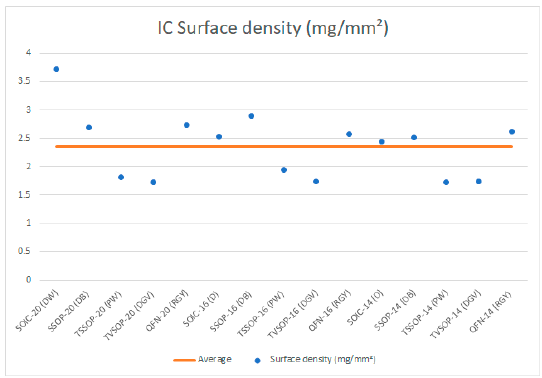
Figure 4. Calculated IC surface density for each package and average.